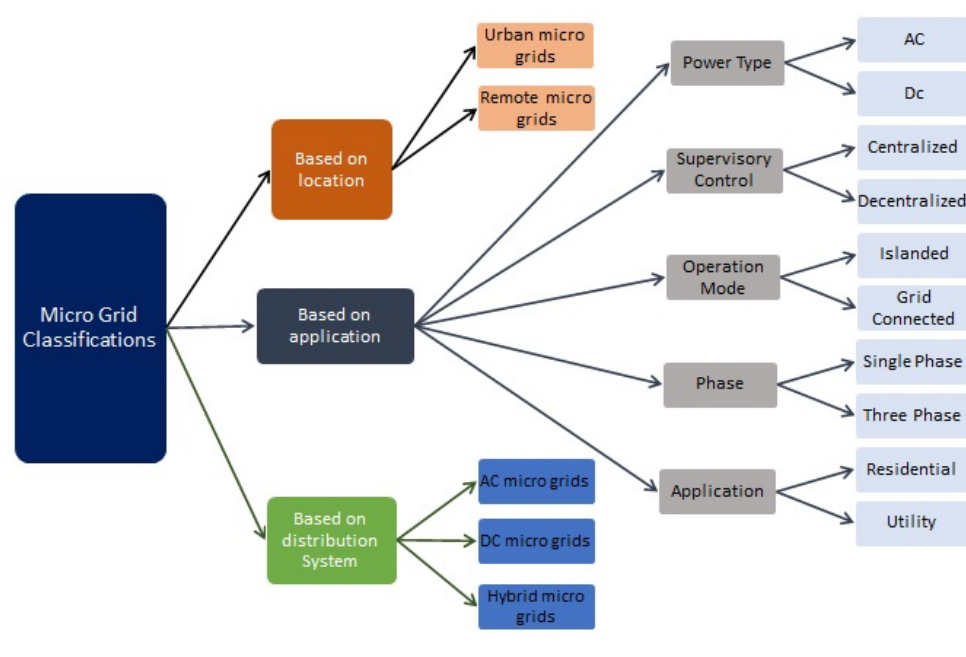
Figure 1. Classification of